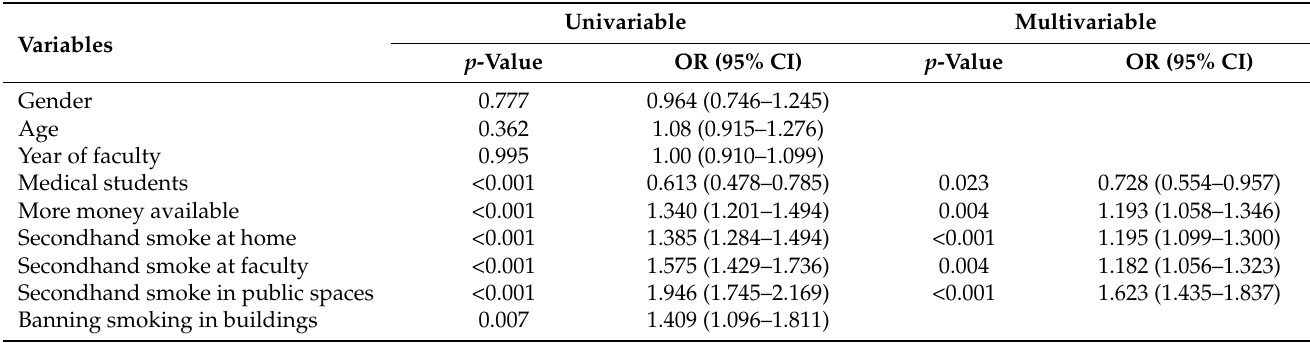
Table 6. Logistic regression